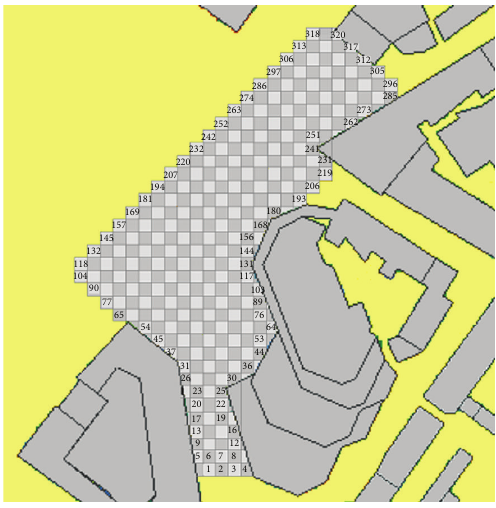
Figure 4: Numeration of the prediction